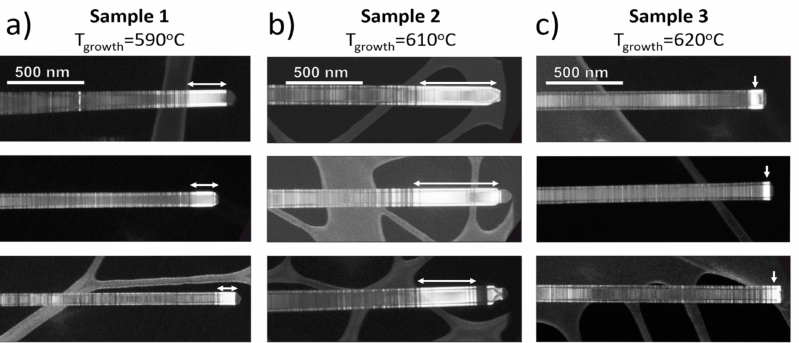
Figure 3. TEM images of NW tips of the studied samples ( a ) Sample 1, ( b ) Sample 2 and ( c ) Sample 3— WZ phase is depicted with white